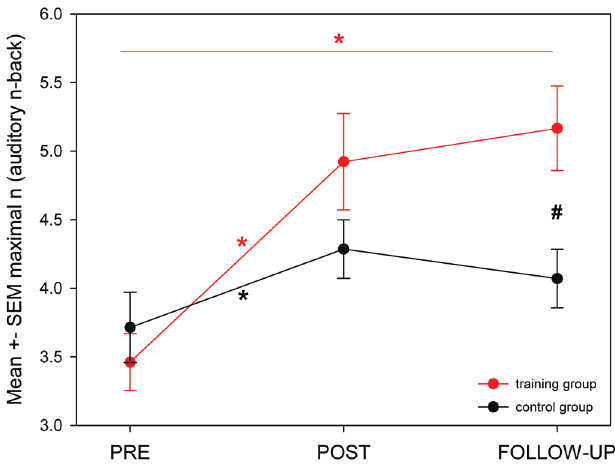
Figure 4. Mean ± SEM of maximal n (auditory n-back, ANB) per group and test session (PRE, POST, FU). The training group showed a significant increase from PRE to POST and to FU. The control group showed a significant increase from PRE to POST, but not FU. * indicates significant changes within group (training (red), control (black); paired t-test, p < 0.05. # indicates significant performance difference at the respective test session (unpaired t-test, p <